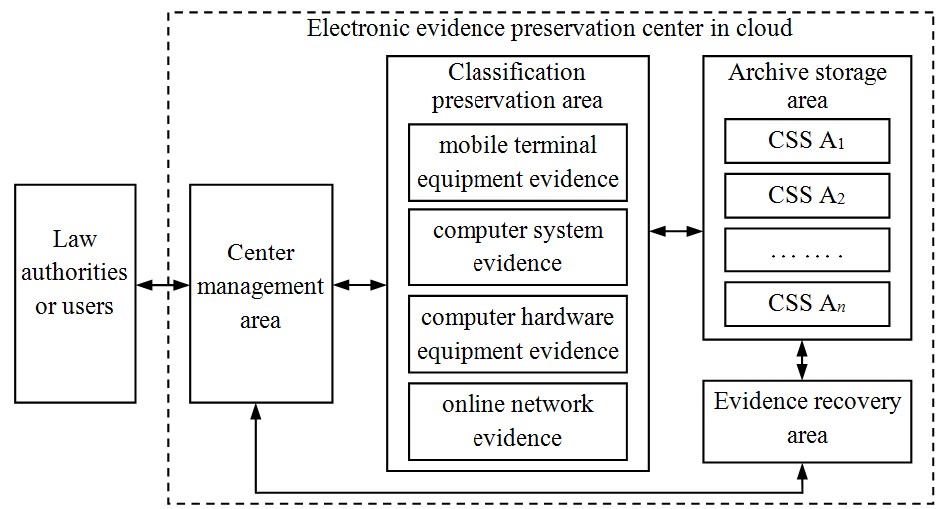
Figure 1. The architecture of electronic evidence preservation center in